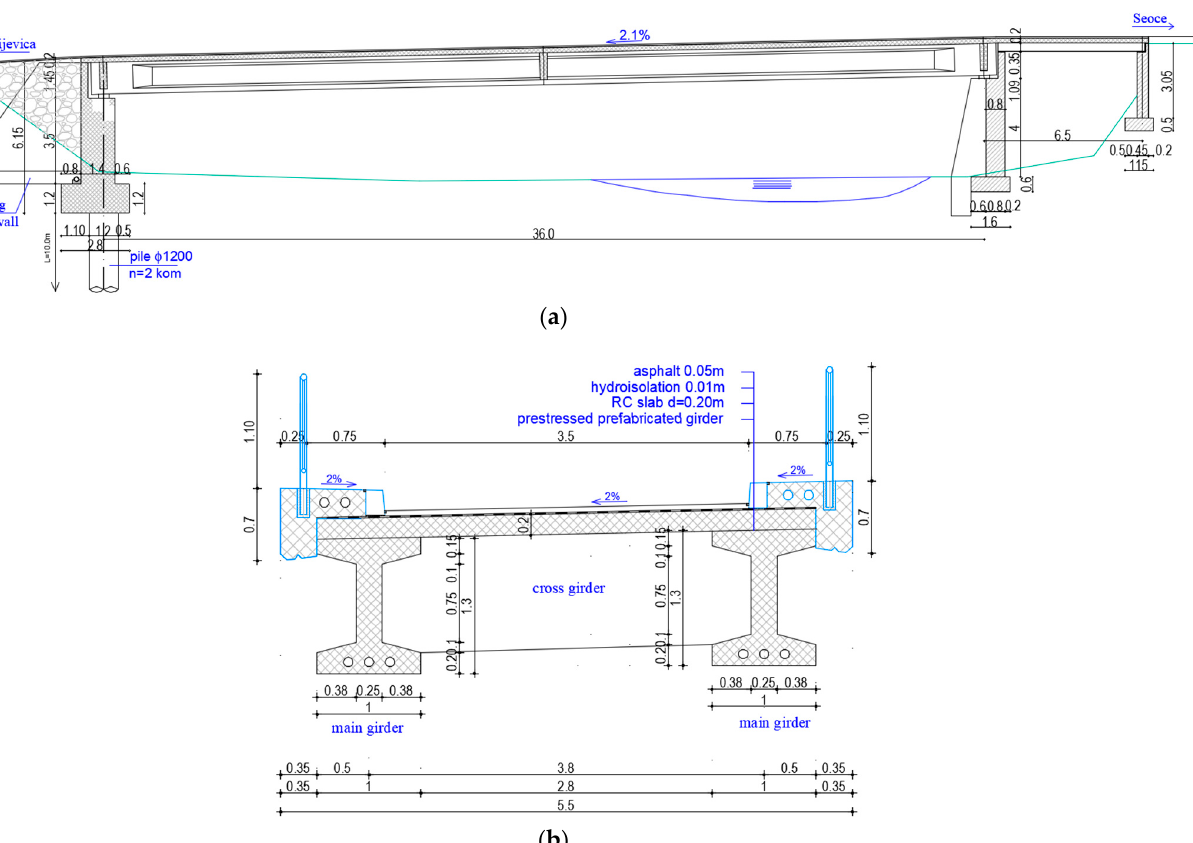
Figure 24. The designed reconstruction of the bridge: ( a ) longitudinal section and ( b ) cross-section in the middle of the span.